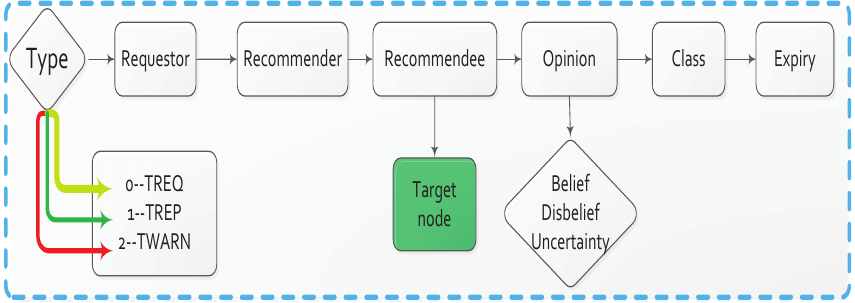
Figure 5. Trust information exchange between interacting nodes using three kind of route information i.e., TREQ, TREP and TWARN are shown with yellow green and red colors.